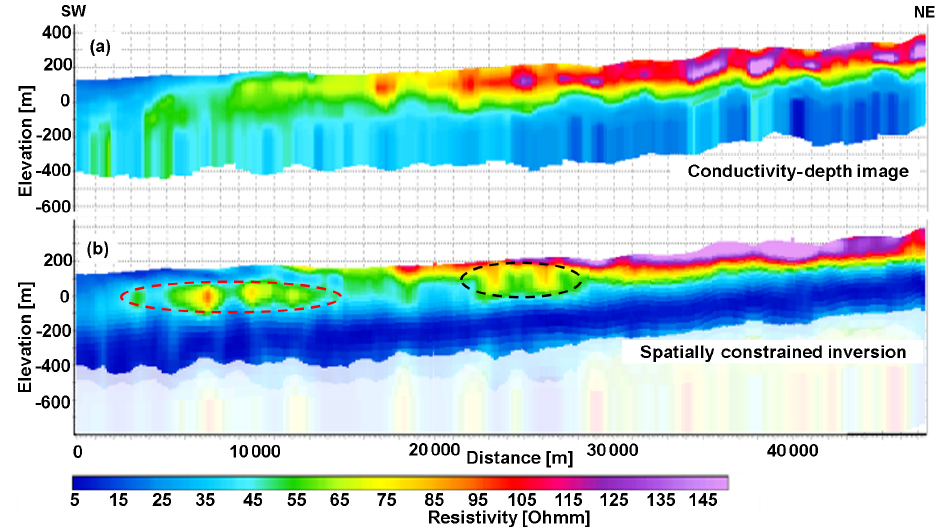
Figure 4. (a) The original conductivity–depth image (CDI) in a portion of NE–SW line 2 (Fig. 1a); (b) the associated results obtained with the new data processing and inversion approach (smooth spatially constrained inversion).